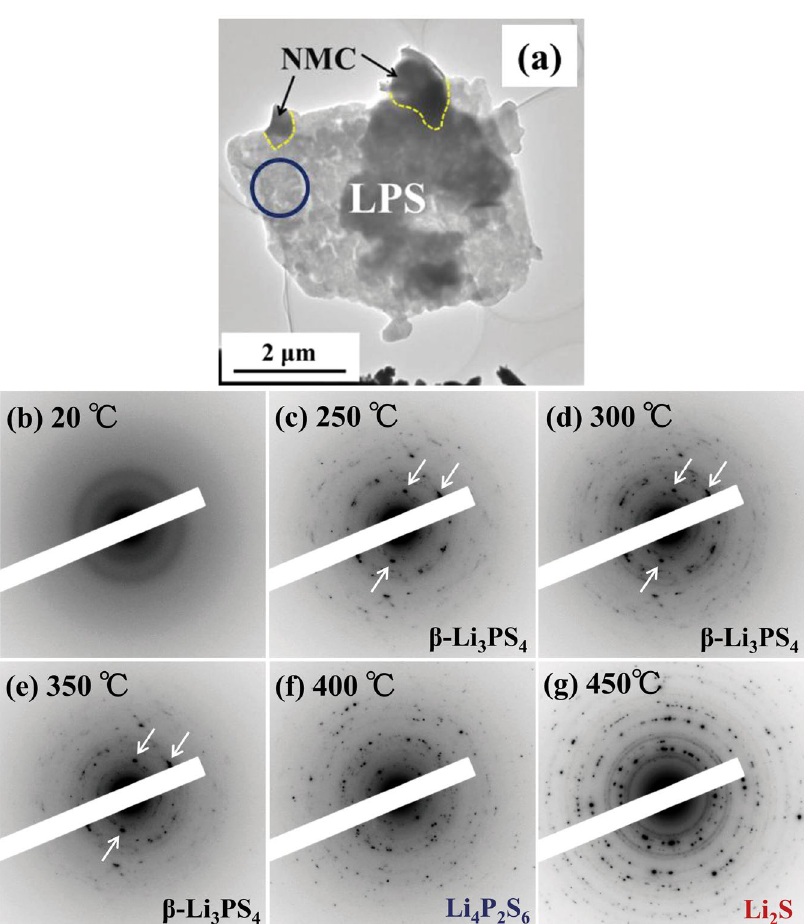
Figure 3. ( a ) The BF image indicating the morphology of the NMC–LPS composites after the initial charge. ( b–g ) Series of ED patterns obtained from the LPS glass area indicated by the blue circle in ( a ) upon heating from 20 °C to 450